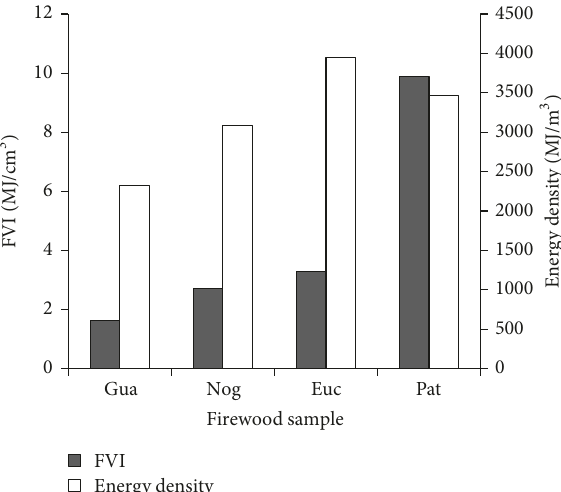
Figure 4: Fuel value index (FVI) and energetic density.